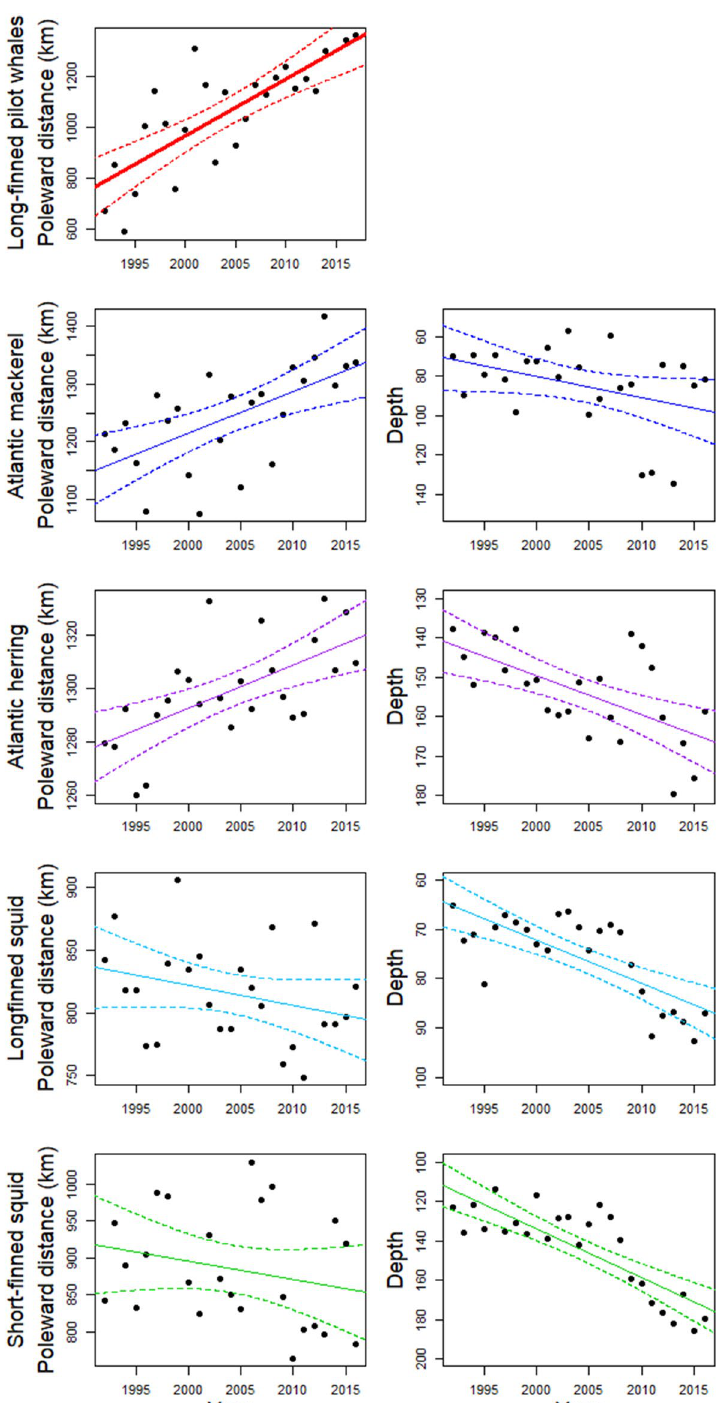
Figure 4. Changes in the mean poleward distance (left panels) and depth (right panels) in the center of distribution of study species from 1992 to 2016. Poleward distance reflects the along-shelf distance measured from Cape Hatteras, North